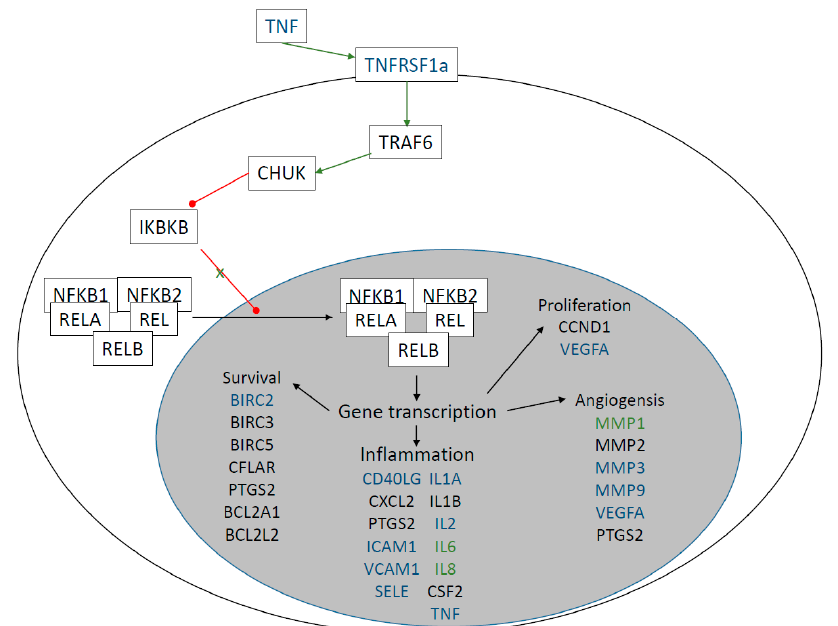
Figure 6. Photodynamic therapy-induced pathway. The proteins highlighted with blue are the proteins that are present in the analyzed panels, while the proteins marked with green indicate those that show statistically significant changes. Green arrows indicate activation, while red arrows indicate inhibition. The pathway was drawn based on Wikipathway WP3617 (www.wikipathways.org/index.php/Pathway:WP3617).